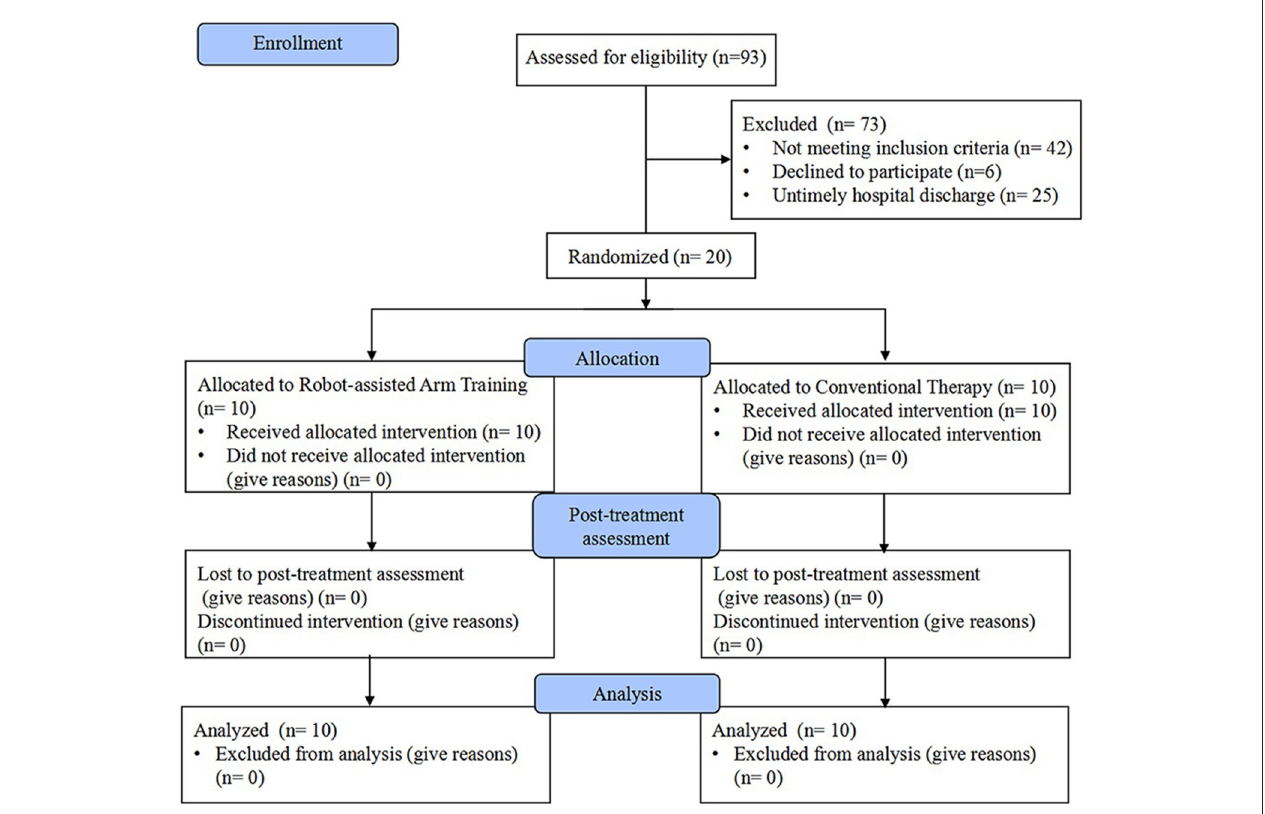
FIGURE 1 | Consolidated Standards of Reporting Trials (CONSORT) flow chart of the study.